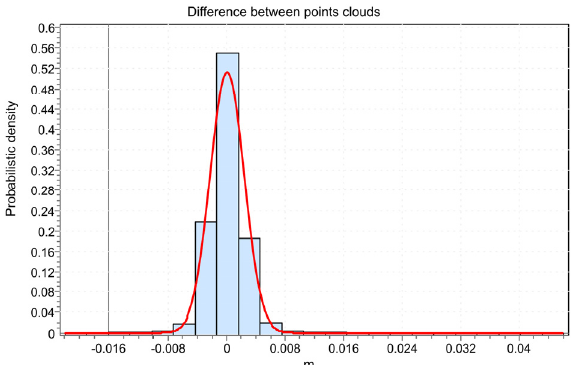
Figure 9. Differences between the 4 points